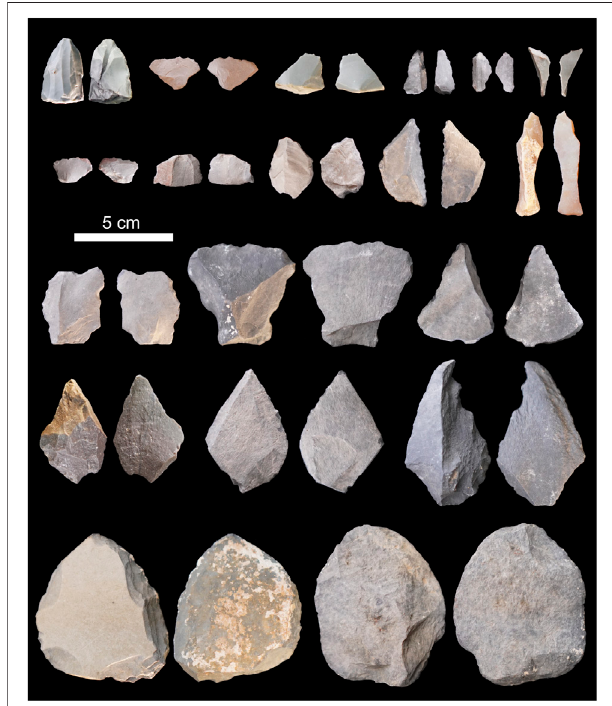
FIGURE 2 | Stone artifacts found in the Siling Co site. Artifacts were collected from the ground surface of sections 17SLC16 and SLC2A in this